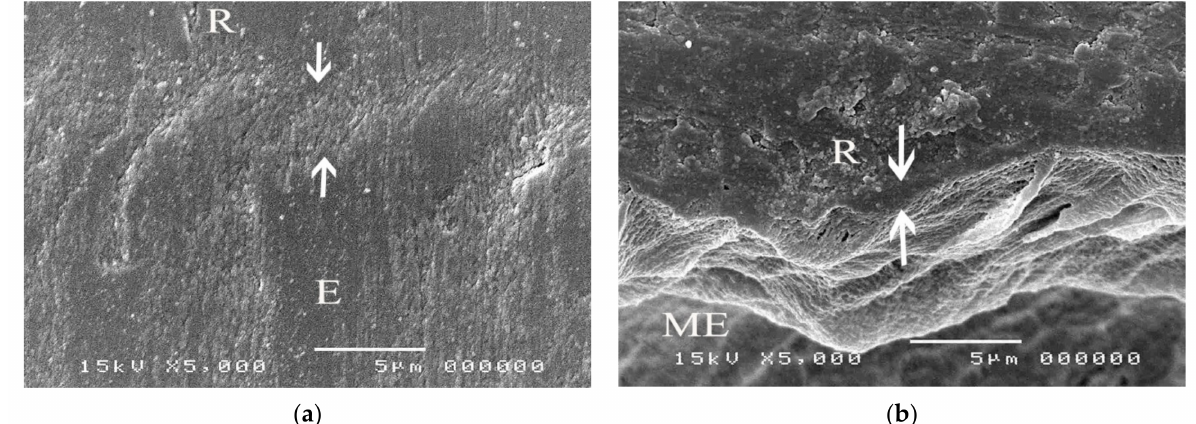
Figure 8. SEM micrographs of fractured ceramic bonded with Super-Bond demonstrating: ( a ) the hybrid layer (arrowed) in a polished specimen and ( b ) the thinner and degradation layer after chemi- cal challenge (original 5000 × , E = experimental biopolymer, R = resin, ME = modified experimental biopolymer).